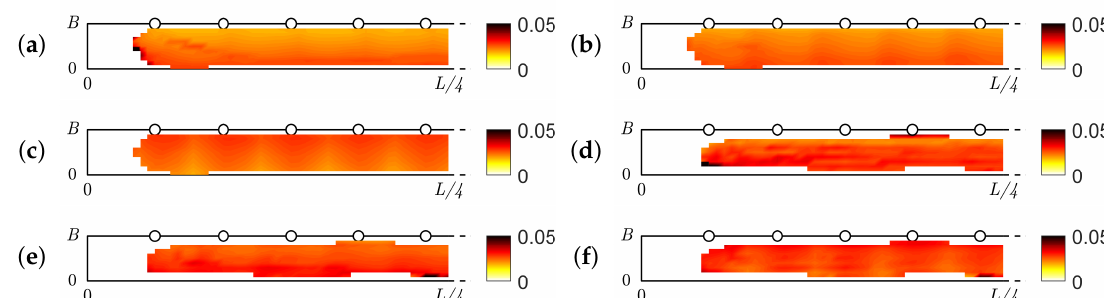
Figure 28. Uncertainty of the trajectories obtained by the static camera setup by representation of the (horizontally projected) time and pedestrian-averaged smoothed state uncertainty matrix ΣΣΣ k distance of the uncertainty in the horizontal direction of the estimated state (depicted for half a bridge deck): walking in case of ( a ) stereo, ( b ) mono and ( c ) mono using the EKF conversion, jogging in case of ( d ) stereo, ( e ) mono and ( f ) mono using the EKF conversion. The corresponding color bar is expressed in meters. The white space corresponds to places where no operational data is available.